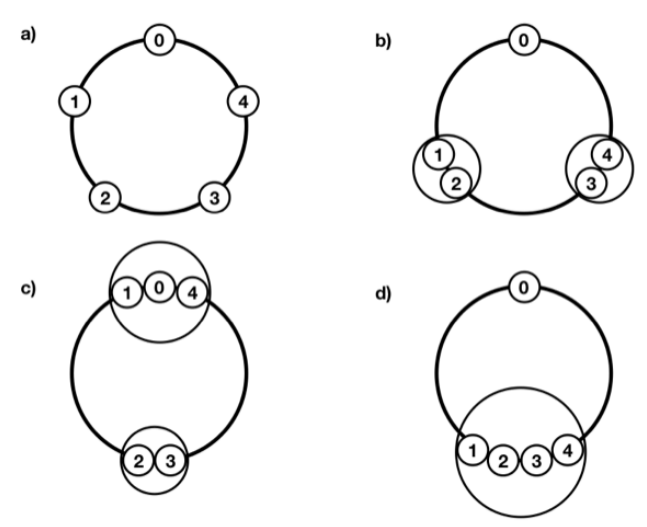
Figure 1: The extended Dynkin diagrams for SU ( 5 ) and its subgroups: a) SU ( 5 ) , b) SU ( 3 ) , c) SU ( 2 ) , and d) SU ( 2 ) . Each node represents a simple root, or the a b a lowest root (indicated by 0). Single lines between roots indicated roots separated by 120 ◦ , the absence of lines connecting roots means that they are orthogonal. The double lines for SU ( 2 ) indicate that the ordinary simple root and the lowest negative root are anti-parallel, since, with one Cartan element the weight space is only one-